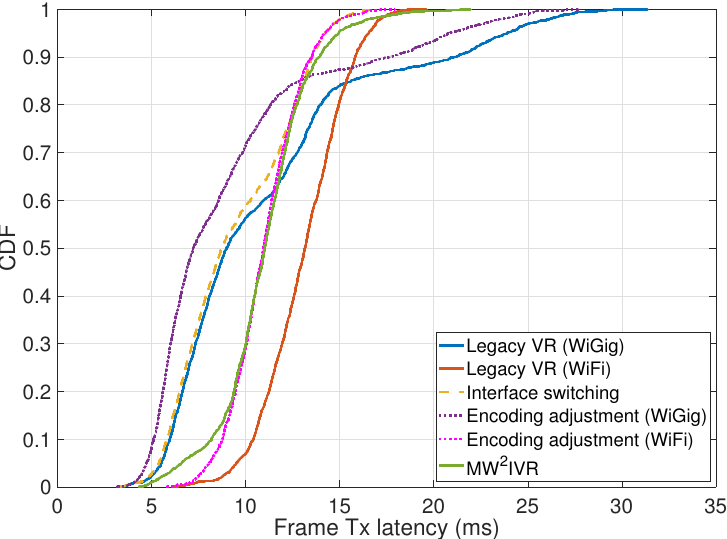
Figure 11. Cumulative distribution function of the frame transmission